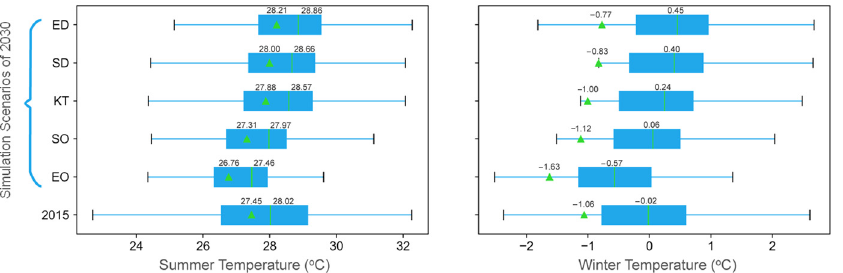
Figure 6. Box plots of simulation results of five scenarios. Black lines stand for the maximum and minimum values, green line represents the median value and the green triangle is on behalf of the mean value.